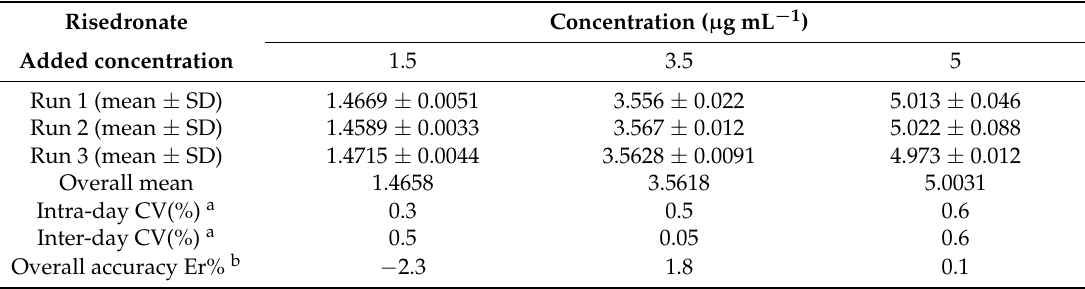
Table 2. Accuracy and precision data.